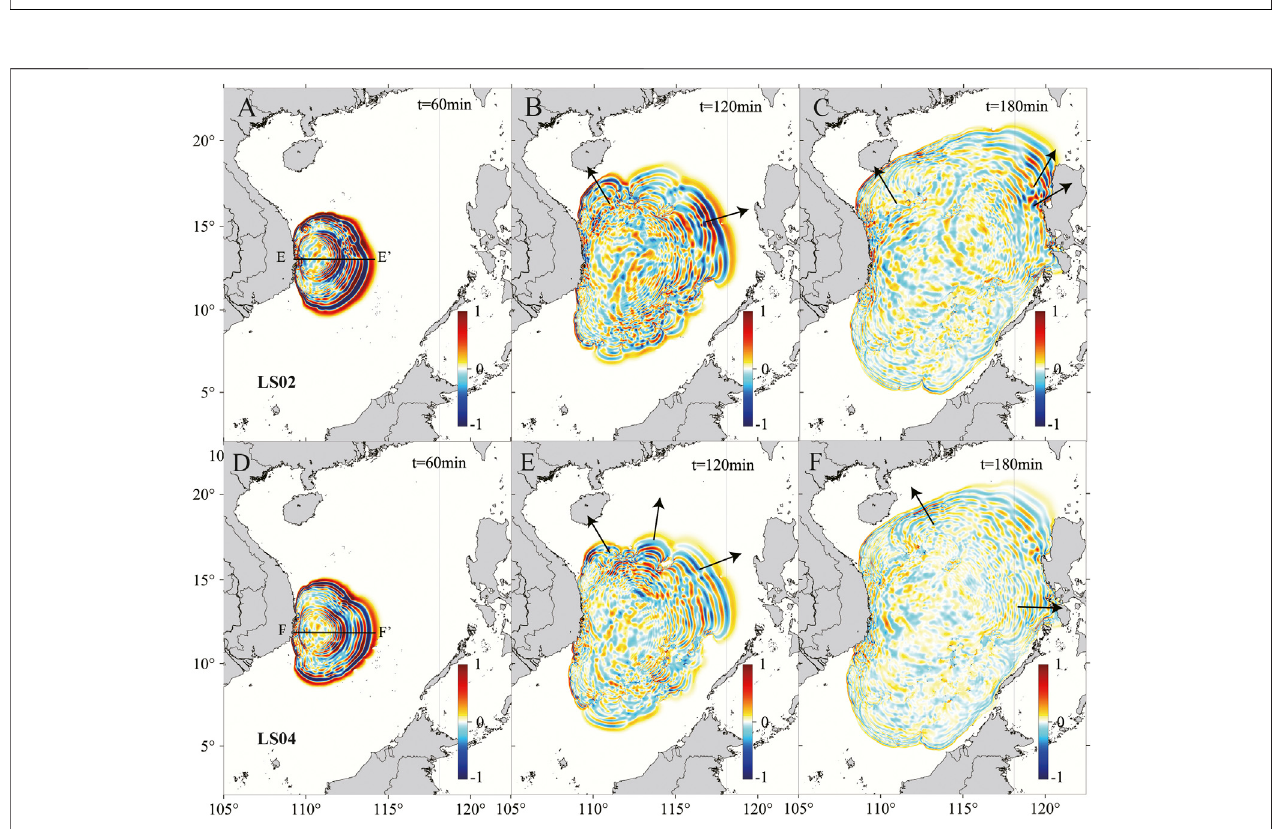
FIGURE 6 | Snapshots of surface elevations simulated by FUNWAVE-TVD at time = 60, 120, 180 min for (A – C) LS02 and (D – F) LS04. Black arrows : the dominant direction of tsunami wave propagation.